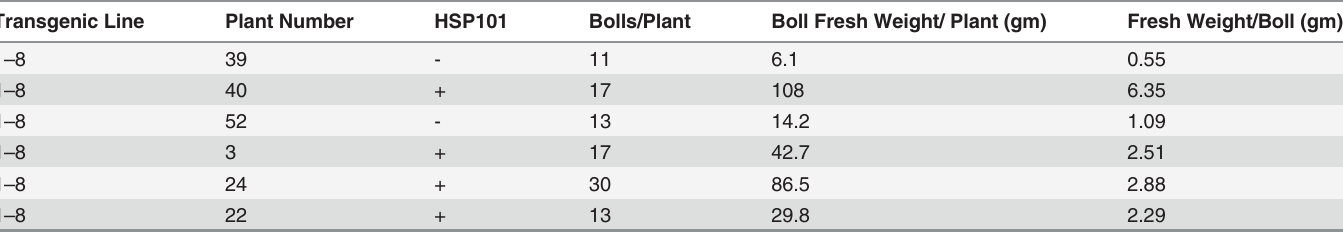
Table 2. Characterization of the relative heat tolerance of AtHSP101 plus and AtHSP101 minus cotton plants from the 1 – 8 cell line. Transgenic Line Plant